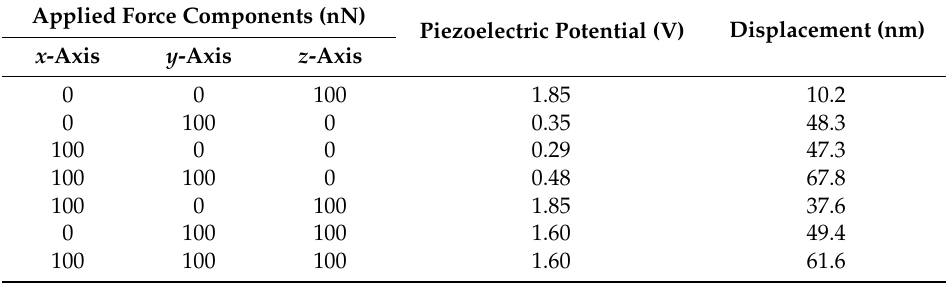
Table 2. Maximum piezoelectric potential and displacement under forces in different